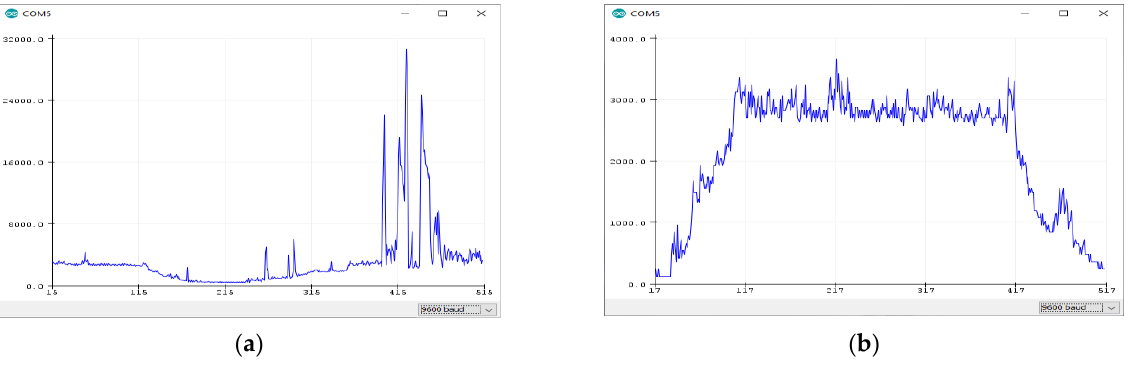
Figure 8. The rotational speed graph provided by the Serial Plotter tool: ( a ) before the signal amplification, the installation of the capacitors and the proper cable shielding; ( b ) after the mentioned improvements.